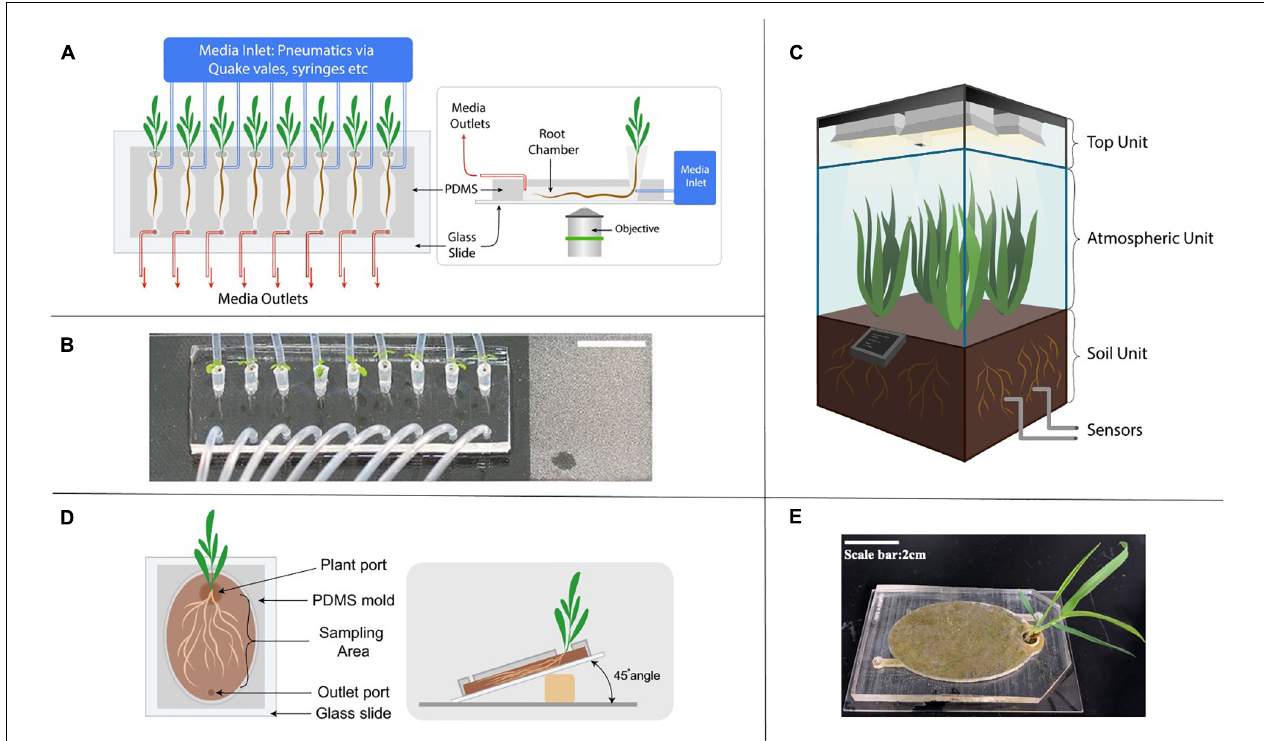
FIGURE 3 | Next generation of growth chamber systems developed to study rhizosphere interactions. (A) Schematic diagram of a representative microfluidic device in studying root response to environmental stimuli. The media inlet is controlled by various pneumatic methods such as syringes and automated Quake-valve system. (B) An image of a RootChip, demonstrating the increased throughput by the parallel growth of 8 Arabidopsis seedlings on a single device (a figure by Massalha et al., 2017). (C) Schematic diagram of an EcoPOD showing three dedicated units with different features; sensors monitor operational parameters closely and the central hub located at the base of the atmospheric unit controls the EcoPOD. (D) Schematic diagram of an EcoFAB with soil sealed to a glass slide. (E) An image of the EcoFAB bonded to glass slide with Brachypodium distachyon grown in